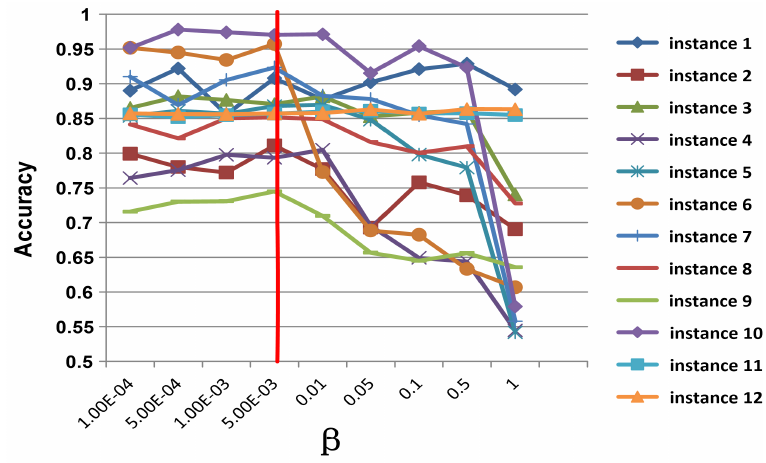
Figure 6. Parameter influence on β of SCSA on ImageNet dataset. The y-axis represents the classifica- tion accuracy of the target domain; the x-axis represents the value range of β .